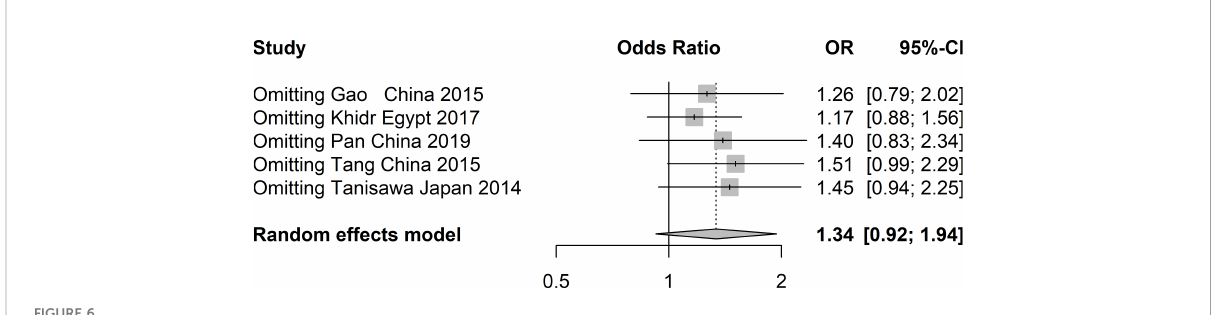
FIGURE 6 Sensitivity analysis of studies included in analysis of rs16835198 and T2DM risk.